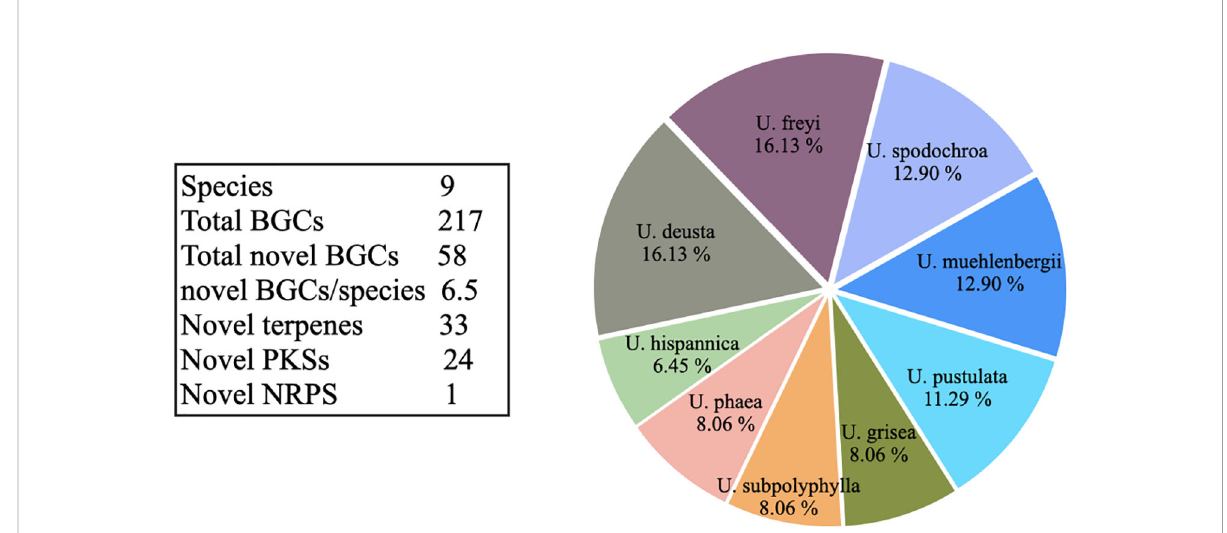
FIGURE 4 Pie chart depicting the contribution of each species to the overall novel Umbilicaria biosynthetic gene clusters (BGCs) (as identi fi ed by BiG- SLiCE, distance threshold T > 900) Each Umbilicaria species contains 4 – 10 unique, species-speci fi c BGCs. Umbilicaria freyi and U. deusta contain the largest number of novel BGCs. The number of novel BGCs is slightly positively correlated to the number of clusters ( R = 0.68). Of 58 unique BGCs ( T > 900), 56.89% were terpene clusters and 41.37% were PKS